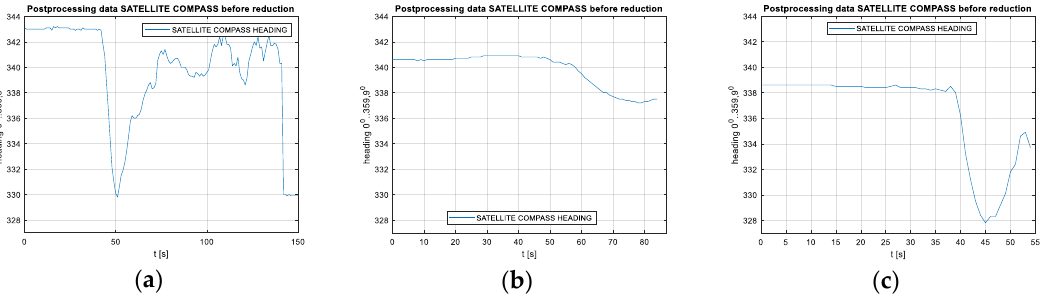
Figure 12. Raw heading records for the Furuno compass for the speeds of 10 km/h ( a ), 20 km/h ( b ) and 30 km/h ( c ).